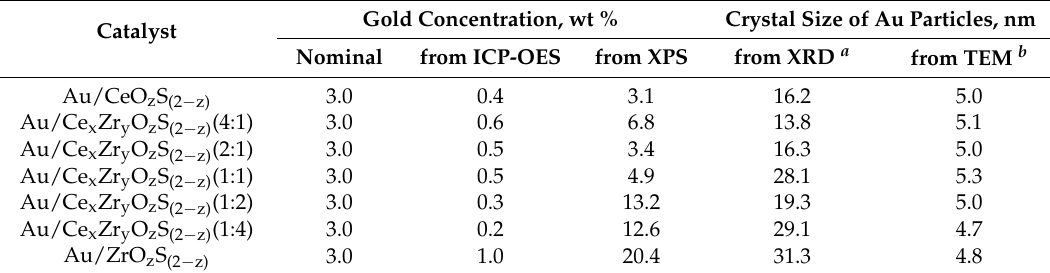
Table 2. The content of gold and size of its